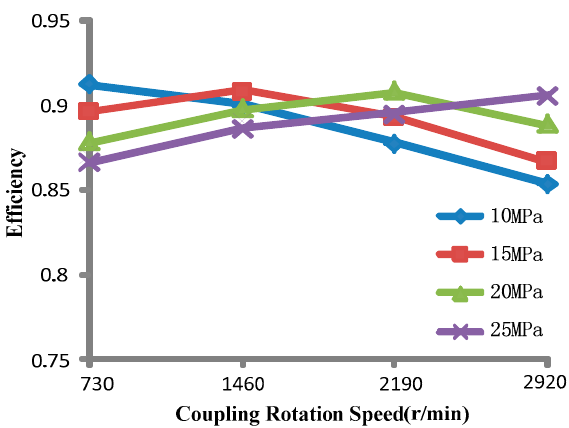
Figure 18. The influence trend of pressure and coupling rotation speed on the efficiency of the mechanical-hydraulic system.